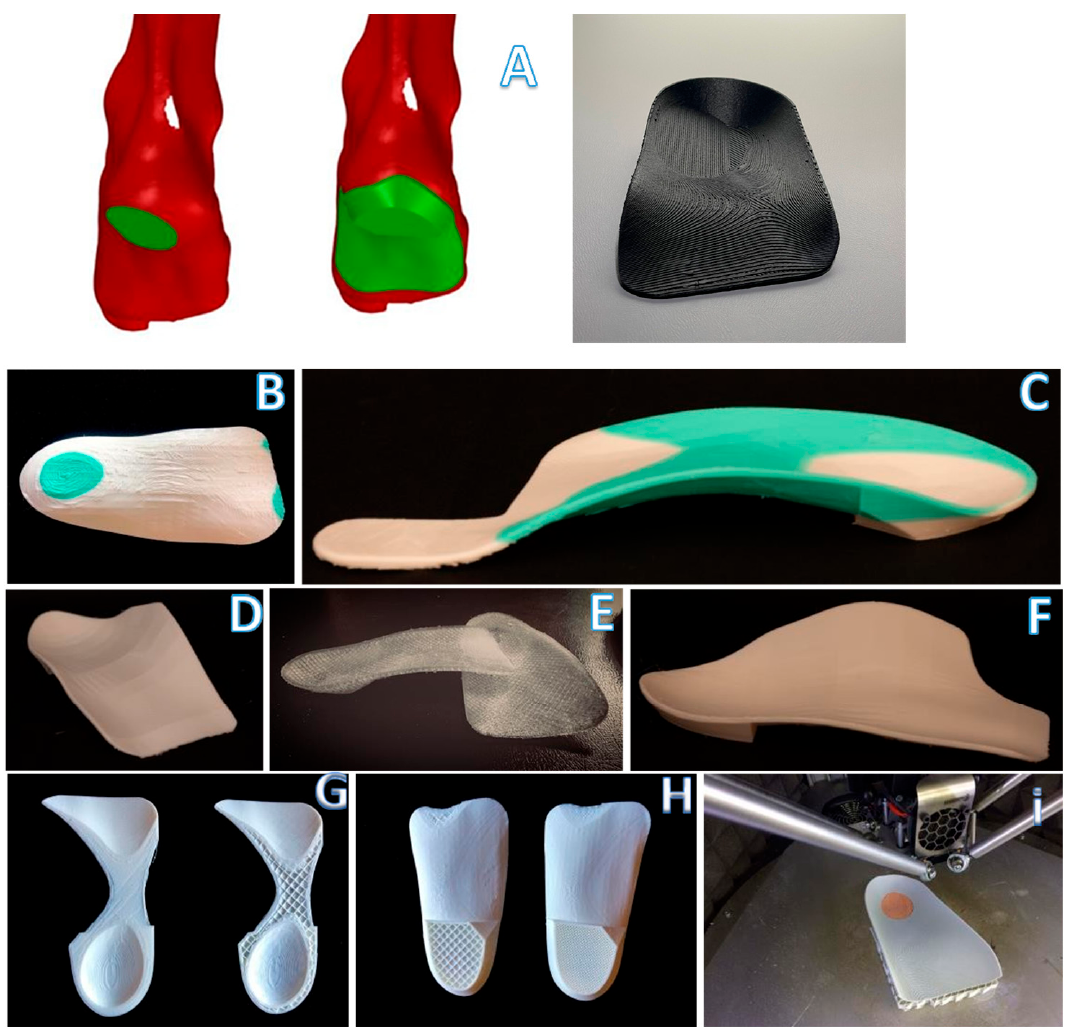
Figure 4. Key steps in the modelling process for the medial heel skive ( A ) and intrinsic corrections: intrinsic rearfoot post ( B ), Morton’s extension ( C ), first ray cut out ( D ), neutral orthosis without corrections ( E ), first met cut out ( F ) and 3D orthotics with different thicknesses and structure types ( G – I ).